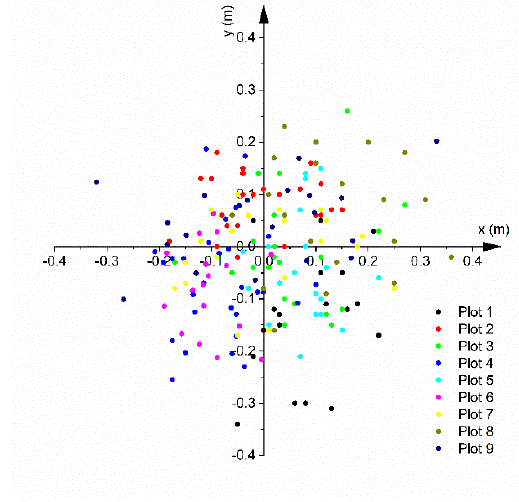
Figure 16. The position errors of all trees in the plots.